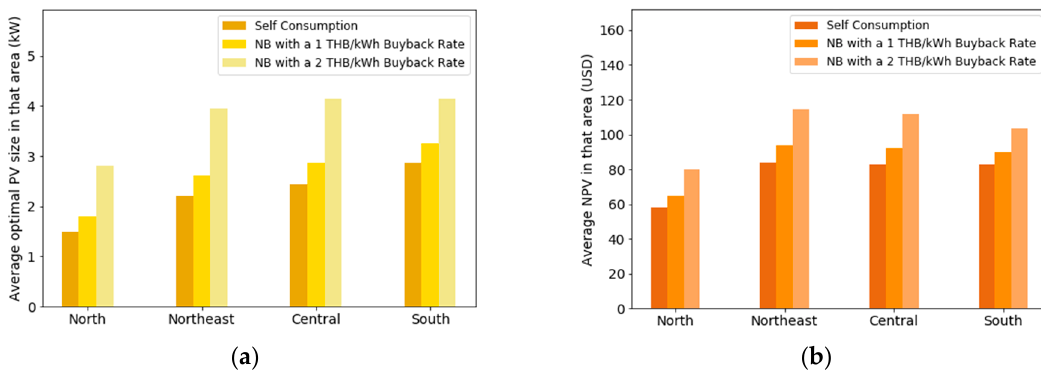
Figure 7. Comparison of ( a ) average optimal PV size and ( b ) average NPV by region for residential customers under a TOU rate. (Note: The average optimal PV size and the average NPV are the average values among all provinces within a region).